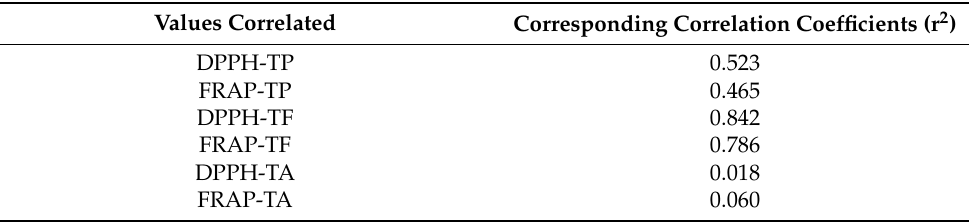
Table 2. Correlations between DPPH, FRAP assay and total phenolics (TP), total flavanols (TF) and total anthocyanins (TA) concentration.